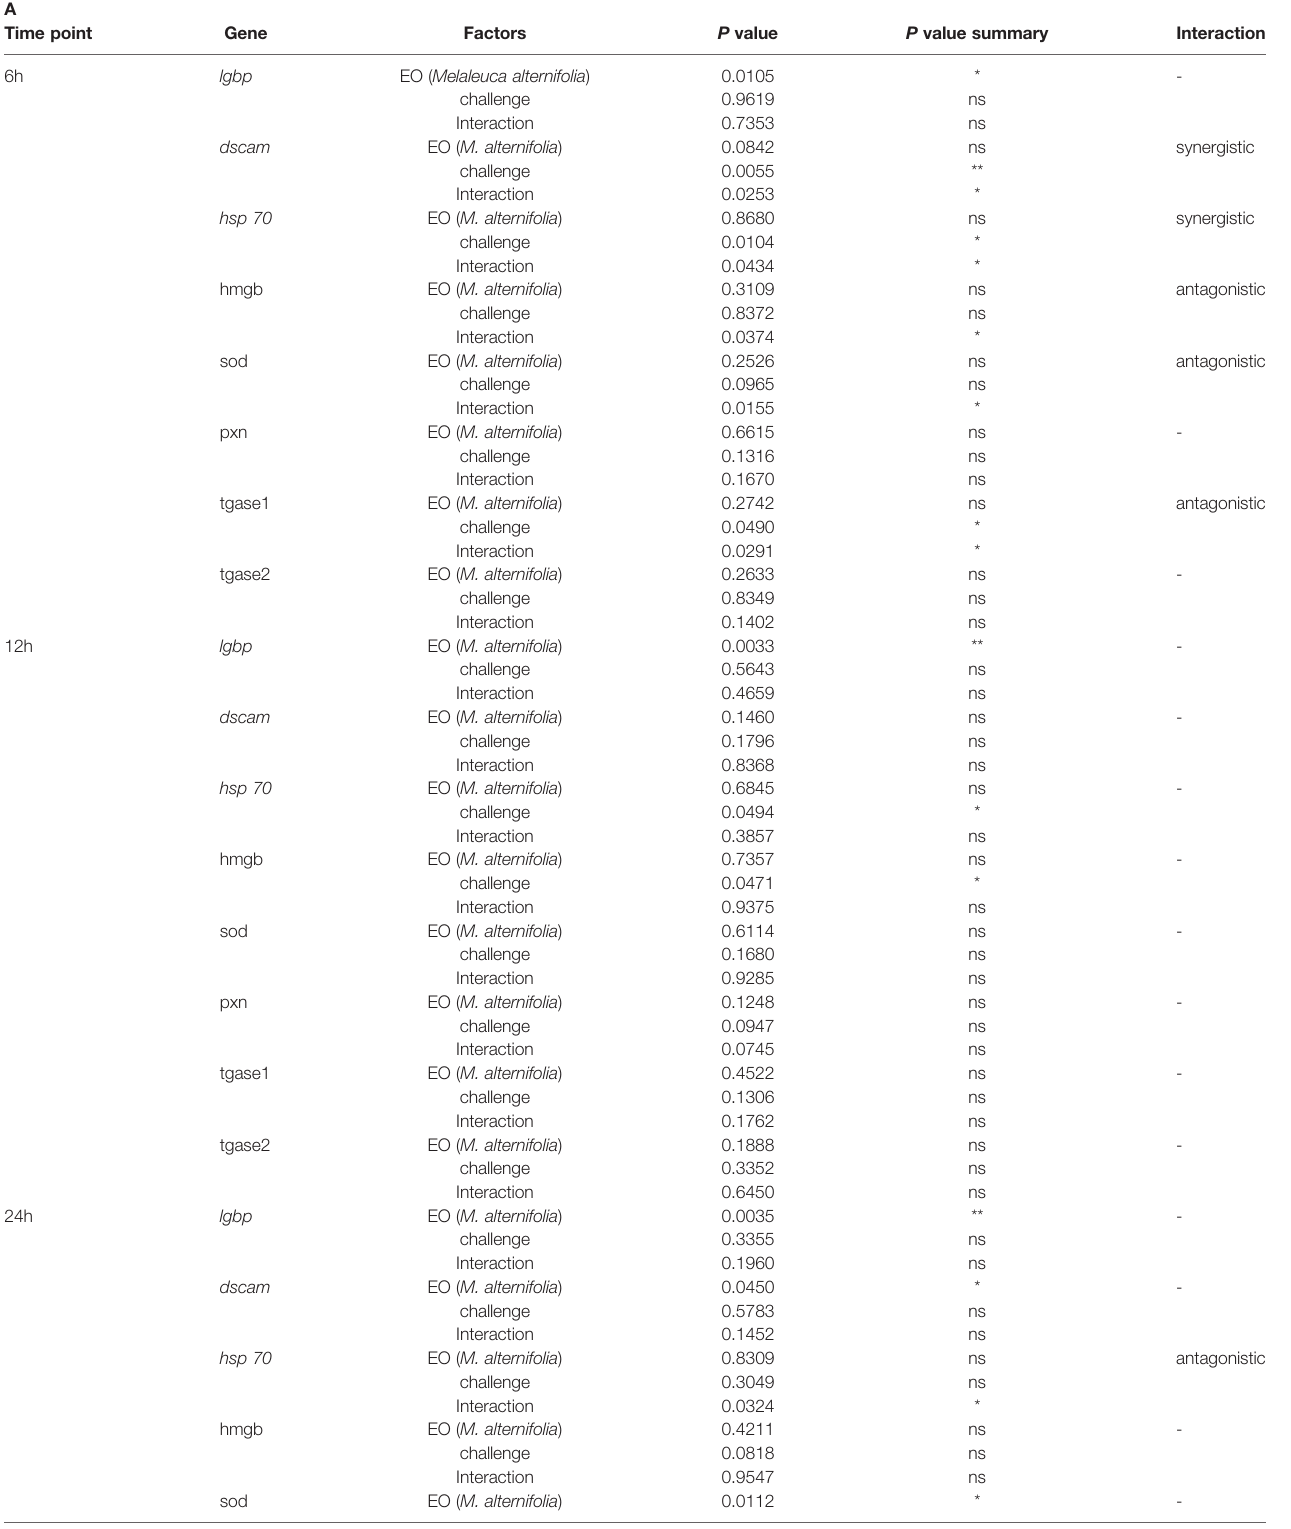
TABLE 4 | Two-way ANOVA showing main and interaction effects of essential oils and with/without Vibrio campbellii challenge on the immune gene expressions of brine shrimp larvae at three different time points (6, 12, and 24 h). A Time